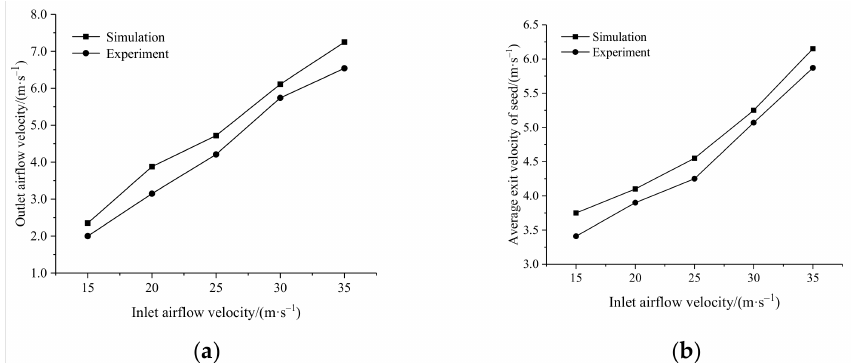
Figure 5. Comparison between simulation and experimental results. Note: ( a ) relationship between outlet airflow velocity and inlet-airflow velocity; ( b ) relationship between the average exit velocity of seeds and the velocity of inlet air